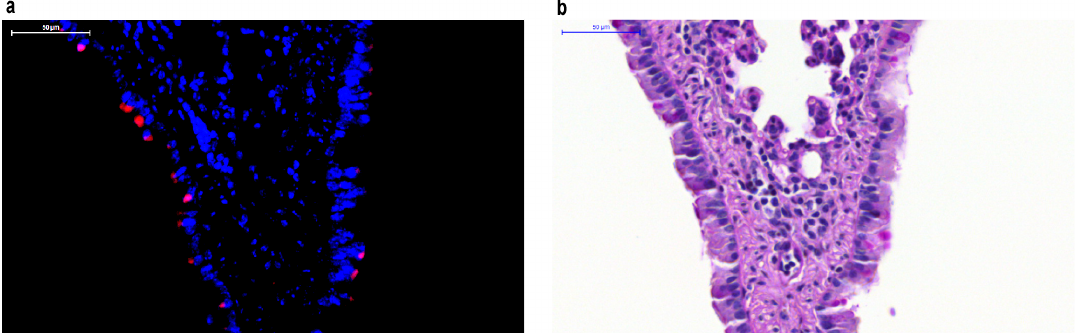
Figure 1. Respiratory syncytial virus (RSV) labeled with monomeric red fluorescent protein mKate2 in mouse lower respiratory tract epithelial cells. ( a ) RSV localizes to the apical surface of respiratory epithelial cells and can be tracked in vivo in paraffin ‐ embedded tissues using mKate2 as demonstrated with fluorescent imaging using 4 ʹ ,6 ‐ diamidino ‐ 2 ‐ phenylindole (DAPI) counterstaining; ( b ) Periodic Acid ‐ Schiff (PAS) stain of the same lung specimen.